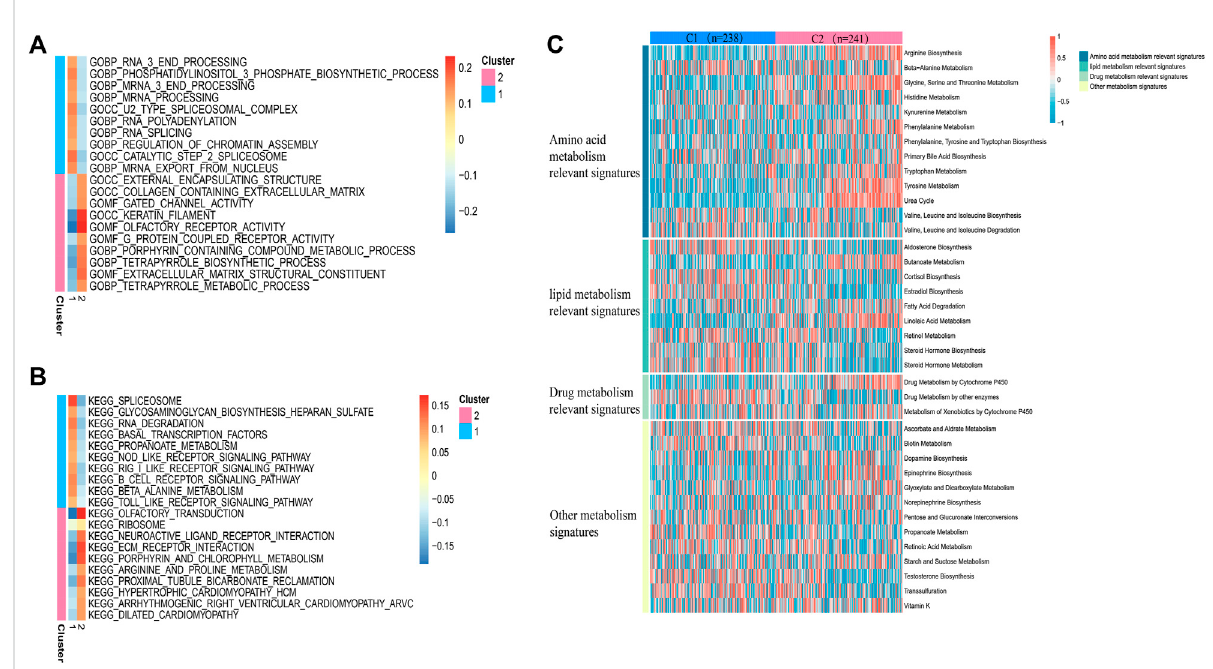
FIGURE 3 Pathway analysis of sepsis pathogenesis. (A,B) 20 pathways with signi fi cant enrichment of GO/KEGG in the two subtypes. (C) Heatmaps of speci fi c metabolic-related pathways.